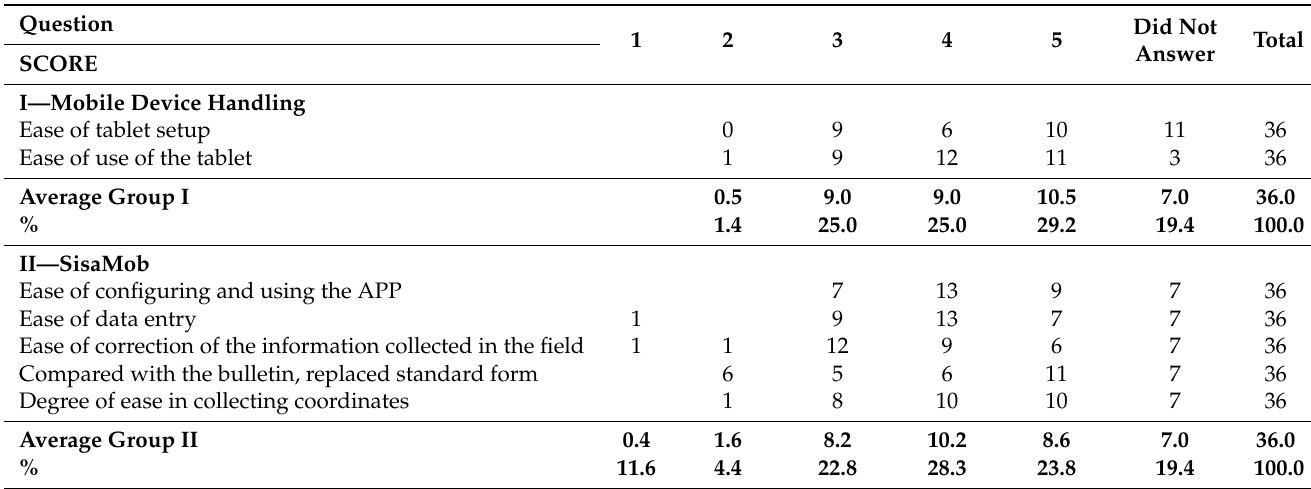
Table 2. Number of participants evaluated and average and percentual for each subgroup, according to questioned criteria and evaluation